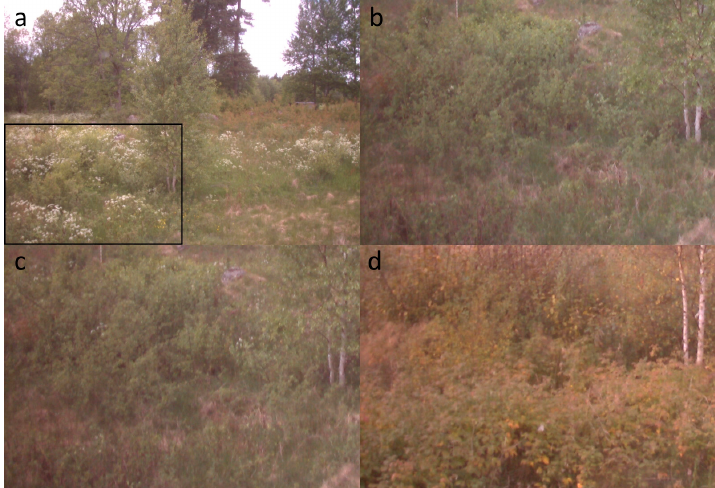
Figure 6. Midday images from the asa site in 2012; shown are ( a ) the full landscape view; and ( b – d ) a sub-region enlarged to show shrub flowering detail; Season Spotter data indicated ( a ) mid-season flowering, 6 June; ( b ) no flowering, 24 May; ( c ) first day of flowering, 25 May; and ( d ) last day of flowering, 20 September (colored leaves mistaken for flowers).